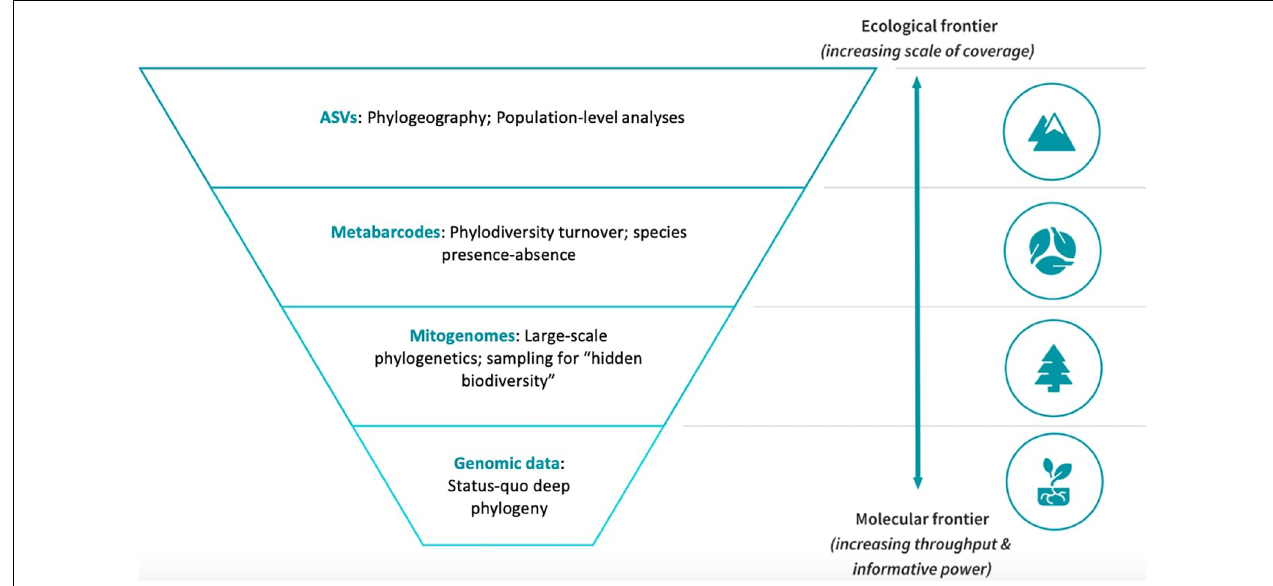
FIGURE 1 | The SITE-100 initiative implements a hybrid approach with different levels of phylogenetic sequencing depth and taxon density. Full genome data are used to represent a limited set of major lineages chosen on taxonomic grounds, while mitogenomes and metabarcodes represent increasing levels of sampling density but with lower sequencing amount. The top level represents intraspecific variation that is assessed using filtered unique ASVs from multiple metabarcoding libraries.